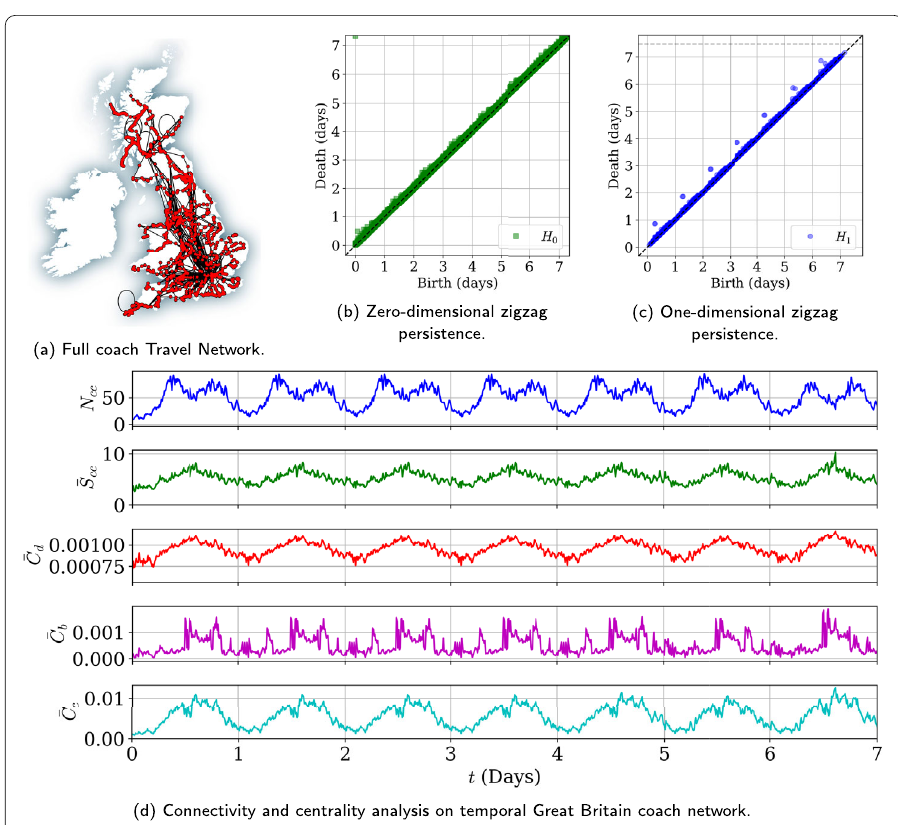
Figure 12 Results for the coach transportation network of Great Britain